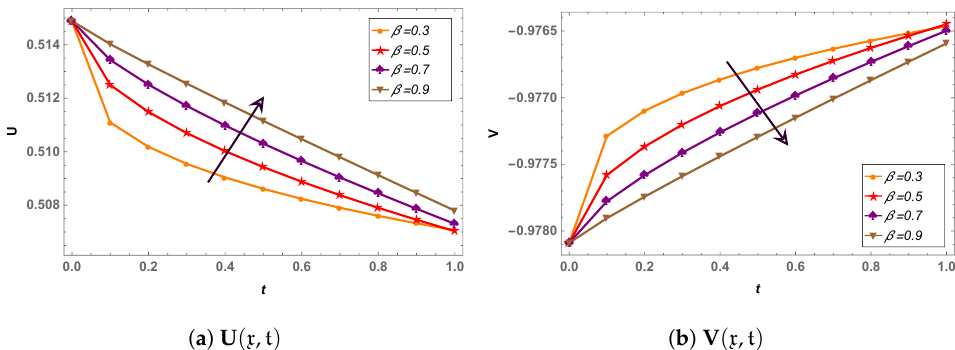
Figure 6. Two-dimensional (2D) plot of LHPM solutions at different β in Example 2 when x = 5 and η = a = 0.3.